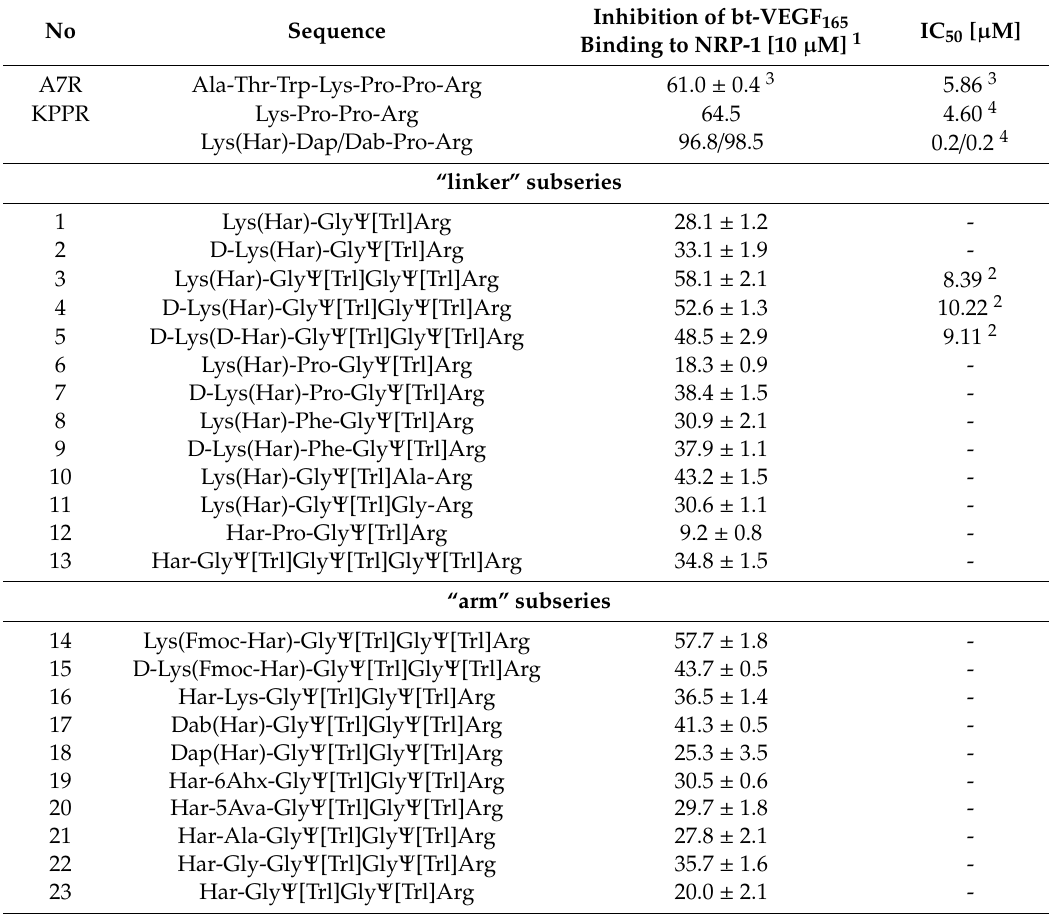
Table 2. Inhibitory activity of the synthesized